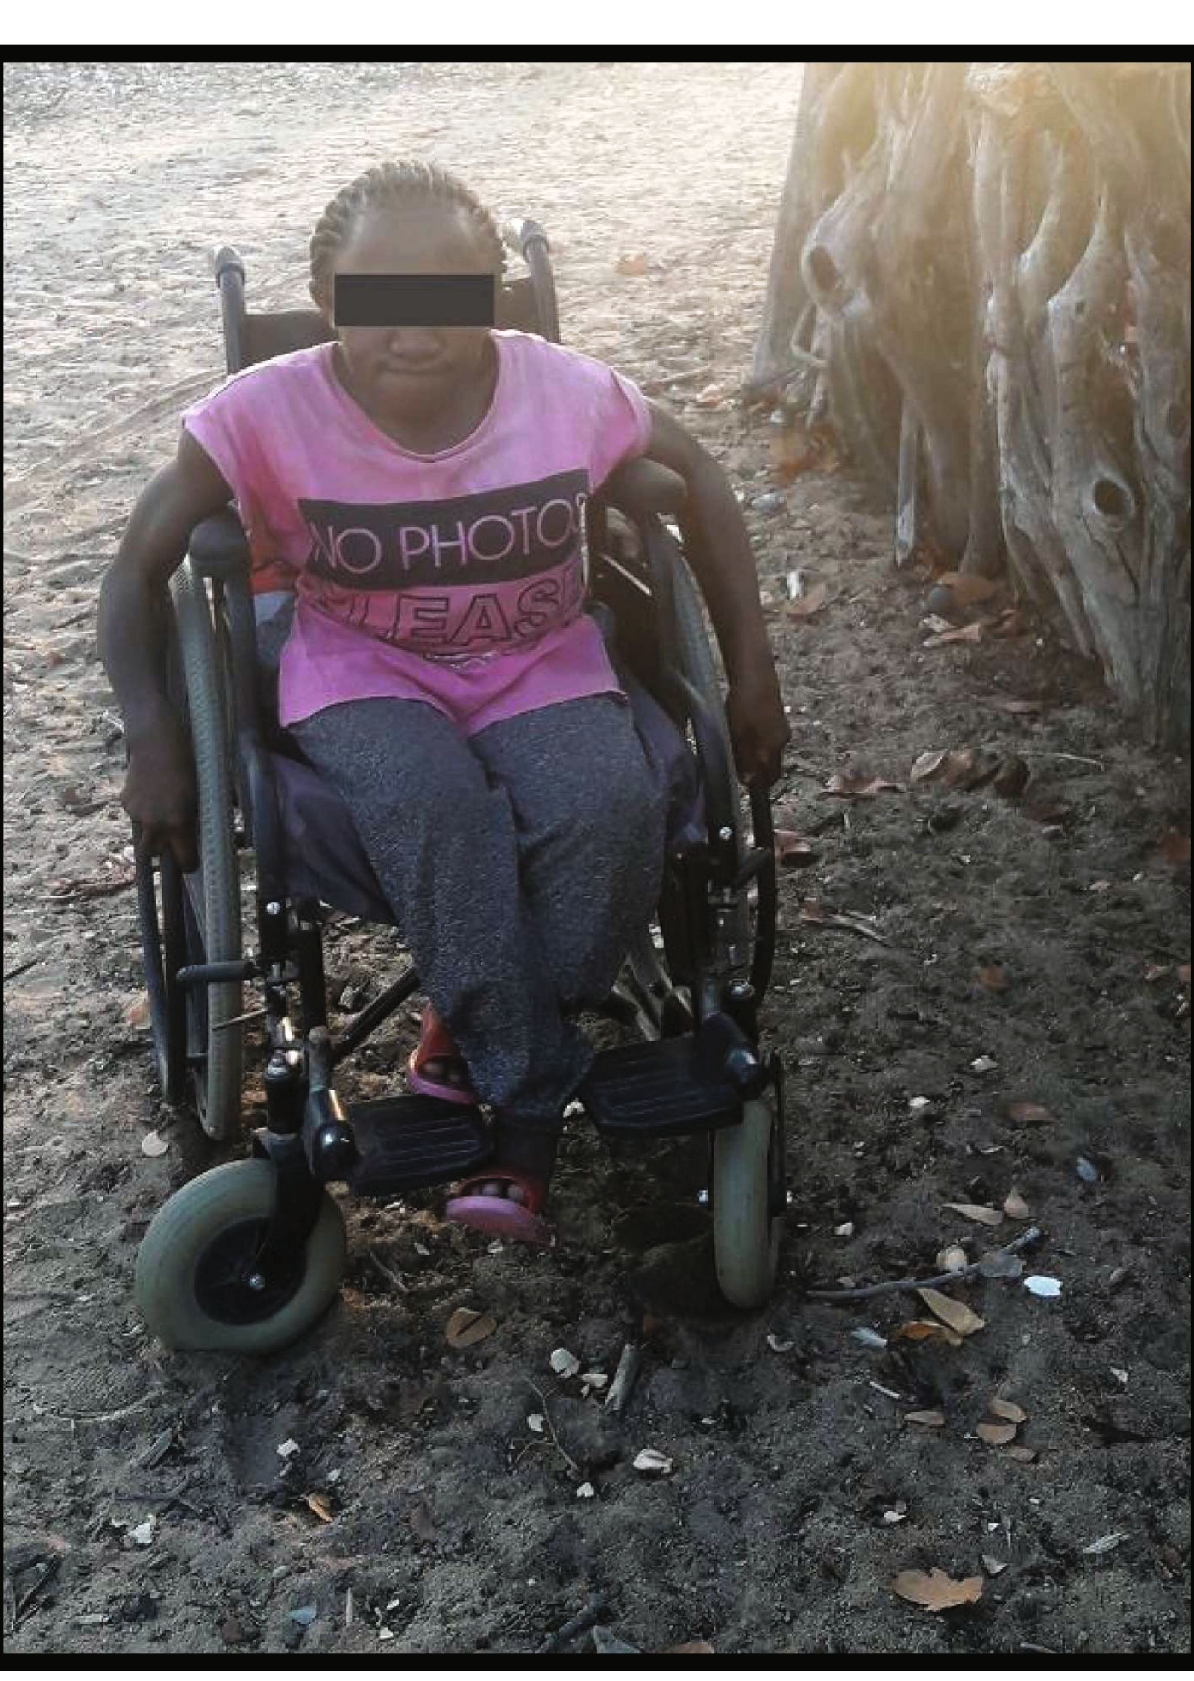
Figure 7: A wheelchair not suitable for sandy